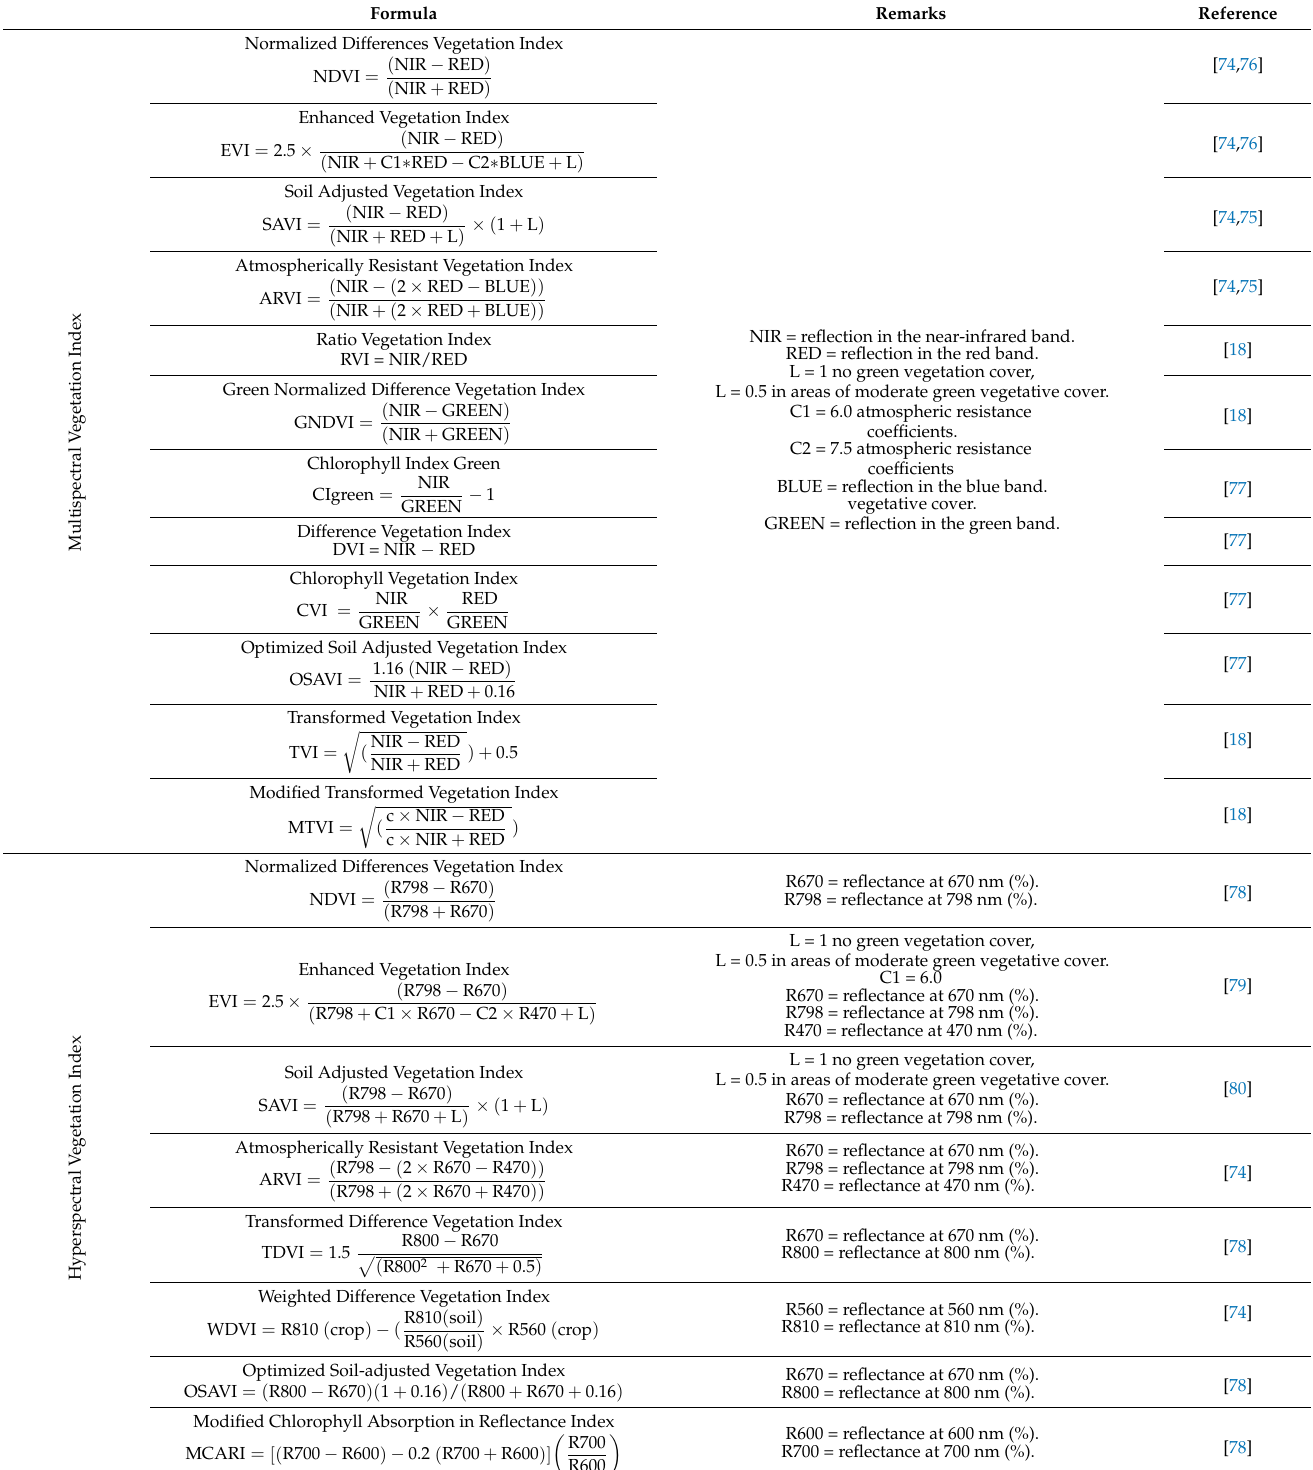
Table 2. Commonly used multispectral and hyperspectral vegetation indices to detect change in vegetation